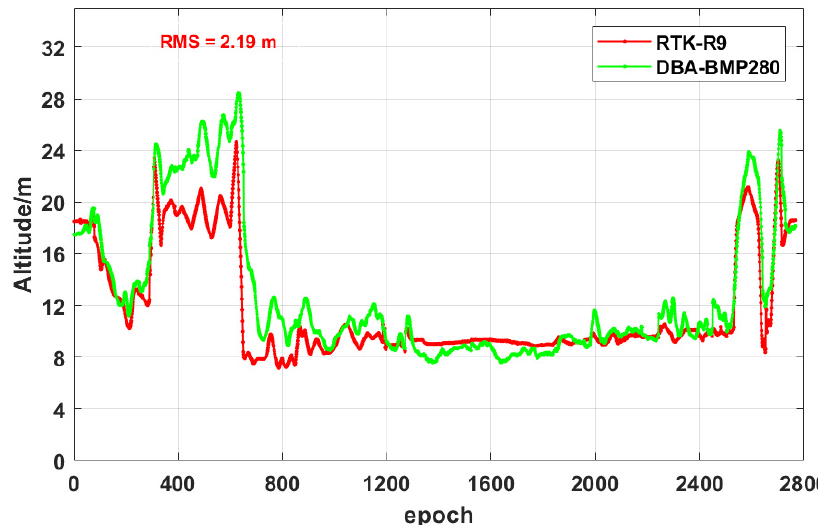
Figure 18. Comparison of the low-cost BMP280 barometer DBA altitude with the Trimble NET R9 reference altitude during the kinematic vehicle experiment in the complex urban environment. The RMSE statistics and deviation sequence of the single-frequency, low-cost u-blox NEO-M8T and the geodetic Trimble Net R9 receiver for both DGNSS and DGNSS/DBA modes in the N/E/U directions are given in Table 7 and Figures 19 and 20. The RMSE of the low-cost u-blox NEO-M8T receiver with single GPS and single BDS in DGNSS mode were 4.33/4.69/8.35 m and 4.91/6.91/19.48 m in the N/E/U directions, respectively, and